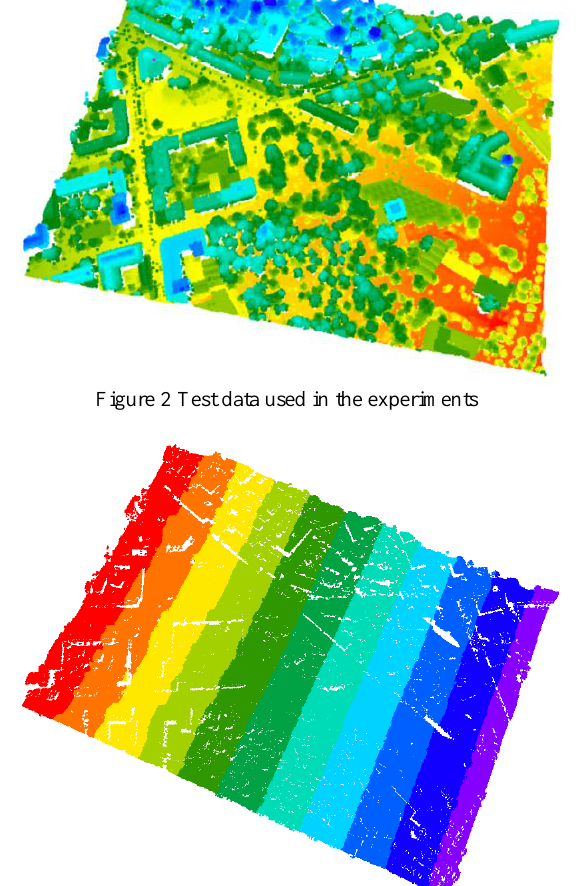
Figure 3 The spanned point cloud. Here for visual clarity spans of 50 m are used. Ideally smaller spans are